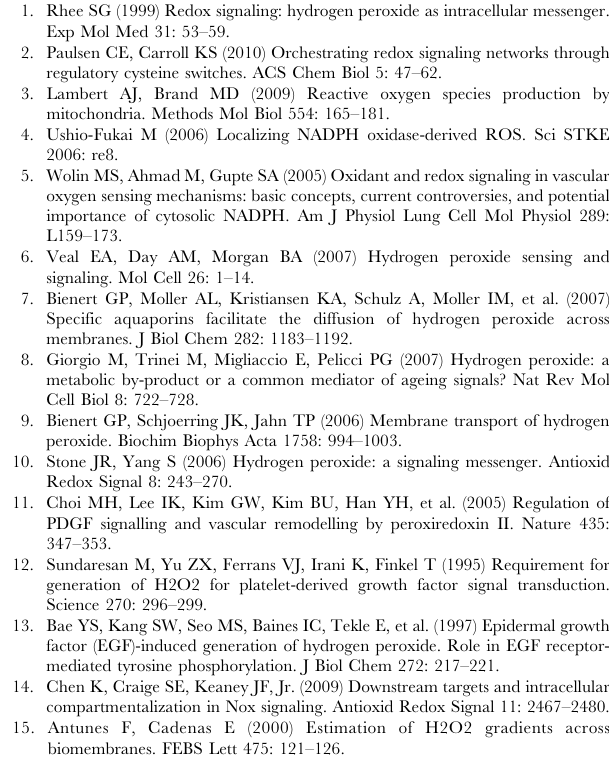
530 nm and excitations at 500 nm and 420 nm. Figure S4 Expression of TR1 in TCMK1 cells. The upper panel shows immunoblot analysis of TR1 expression in TCMK1 cells (lane 1) and TCMK1 siTR1 cells (lane 2). The lower panel shows protein staining as a loading control. Figure S5 Redox state of HyPer targeted to different compart- ments in TR1 knockdown TCMK1 cells treated with diamide. TR1 knockdown and control TCMK cells stably expressing HyPer in the cytosol were treated for 30 min with indicated concentra- tions of diamide. Fluorescence intensity ratio was obtained using emission at 530 nm and excitations at 500 nm and 420 nm. Data represent mean of 3 measurements, 6 standard deviation. Figure S6 Ero1 mRNA levels in knockdown cells. mRNA was isolated from Ero1 siRNA-transfected and scrambled siRNA- transfected HEK 293 cells and subjected to semi-quantitative RT- PCR. Lanes represent RNA isolated from cells transfected with scrambled siRNA (lanes 2 and 4) and Ero1 siRNA (lanes 3 and 5). Molecular weight markers are shown in lane 1. Figure S7 Knockdown of Ero1 or QSOX1 does not affect redox state of HyPer in HEK 293 cells. HEK 293 cells stably expressing HyPer in the ER were transfected with control (non-targeting), Ero1 or QSOX1 siRNAs. Fluorescence intensity was recorded 48 h after transfection. In addition, cells were treated with 1 mM DTT and 100 m M H 2 O 2 to determine the range of oxidation states of HyPer in cells. Data represent mean of 3 independent measurements.